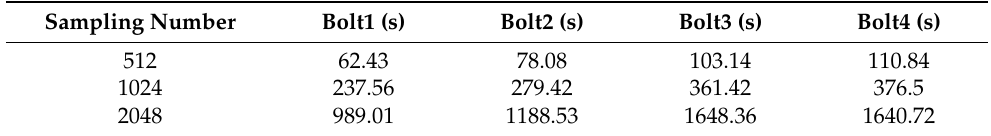
Table 4. FPS sampling